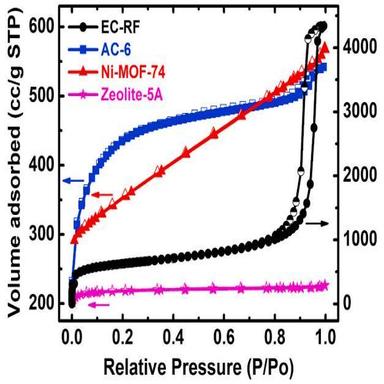
N2 sorption isotherms at 77 K of EC-RF (right axis), AC-6, Ni MOF-74, and Zeolite 5A (left axis) reproduced with permission from Refs., copyright 2017 The Royal Society of Chemistry, and other samples (left arrows/left axis) as shown.